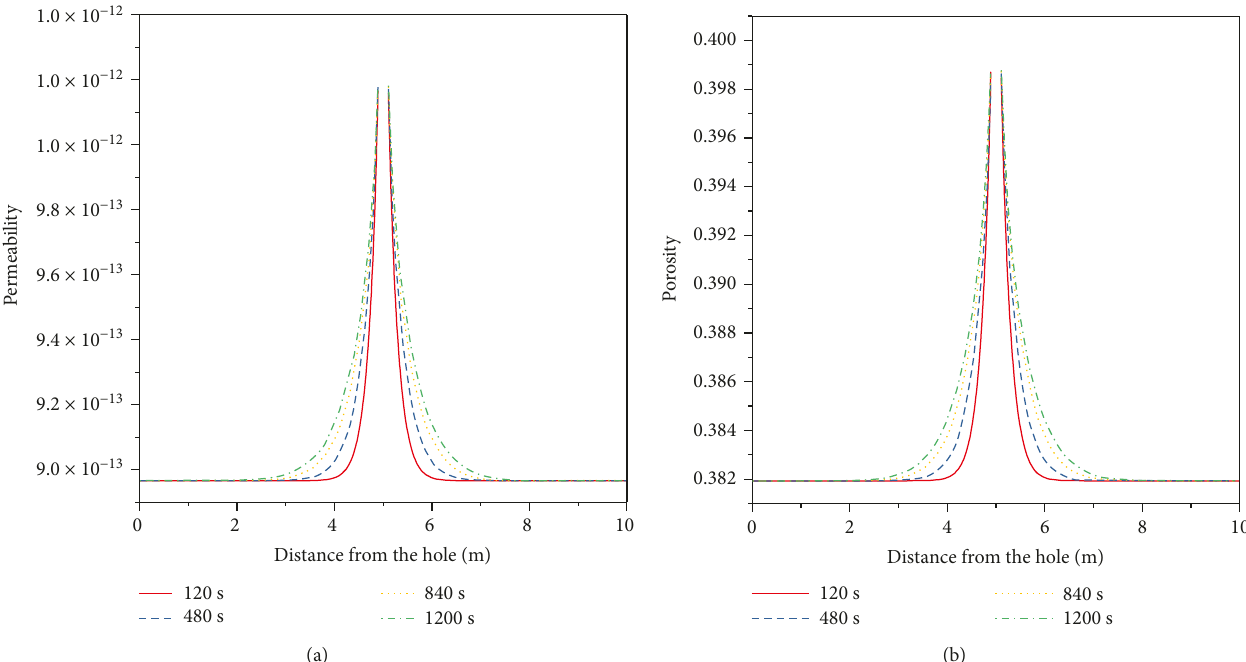
Figure 17: Variation of permeability and porosity over time (W: C=7 :1, p = 2 MPa): (a) porosity and (b) permeability.